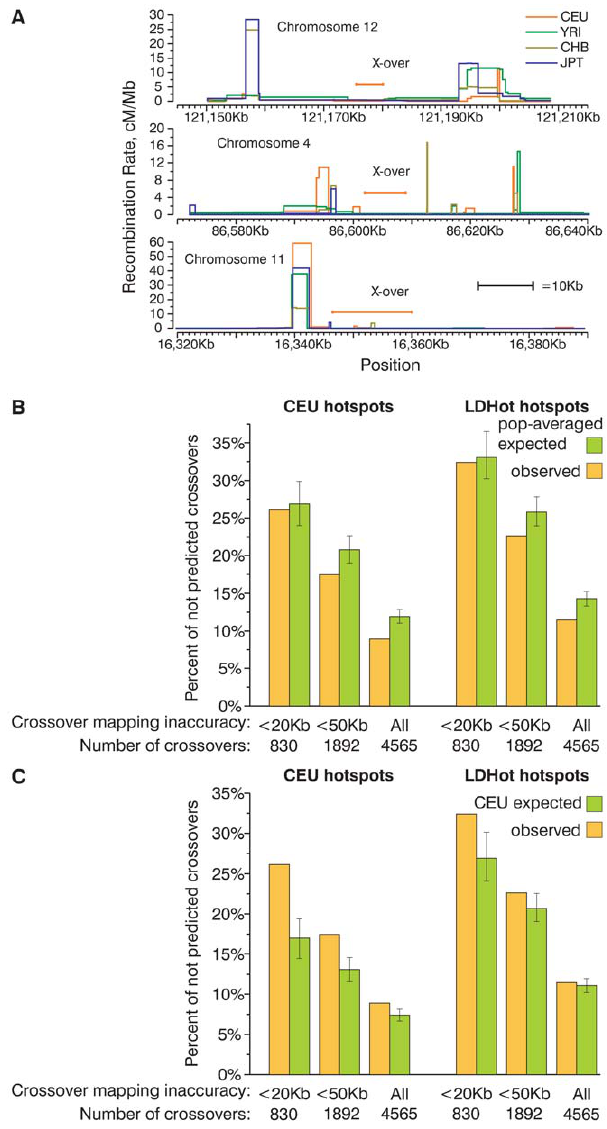
Figure 1. A substantial fraction of present-day crossovers is not predicted by historic recombination rate profiles. (A) Examples of small present day crossover intervals that do not overlap historic hotspots. (B,C) Percentage of present-day crossovers in CEPH families not predicted by overlapping hotspots. The percentages of crossovers that do not overlap CEU and LDHot hotspots were calculated for several subsets of all crossovers defined with various degrees of accuracy. For comparison, the same percentage was calculated for crossovers distributed according to probabilities determined by population- averaged (B) and CEU (C) recombination rate maps. Mean and 95% CI are plotted on the graph. A large fraction of crossovers is not predicted by